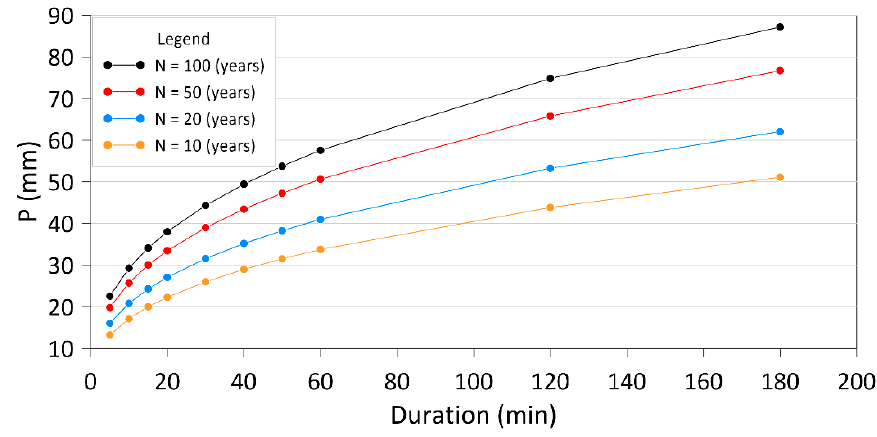
Figure 13. The future downscaled design rainfall intensities for the Vyšná Boca climatological station.